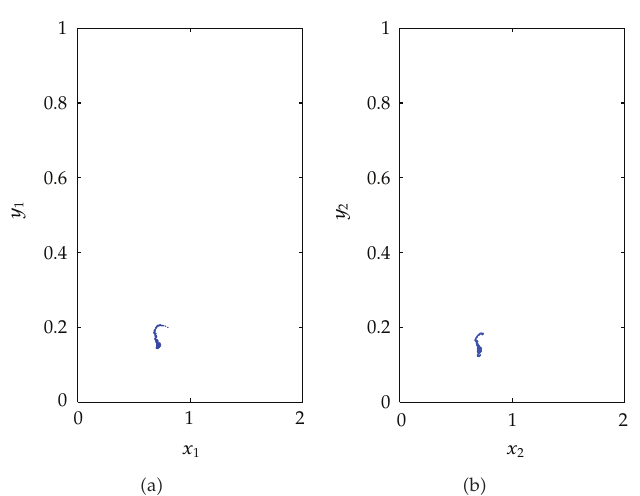
(cid:3) . (cid:5) ,y ∗ 1 1